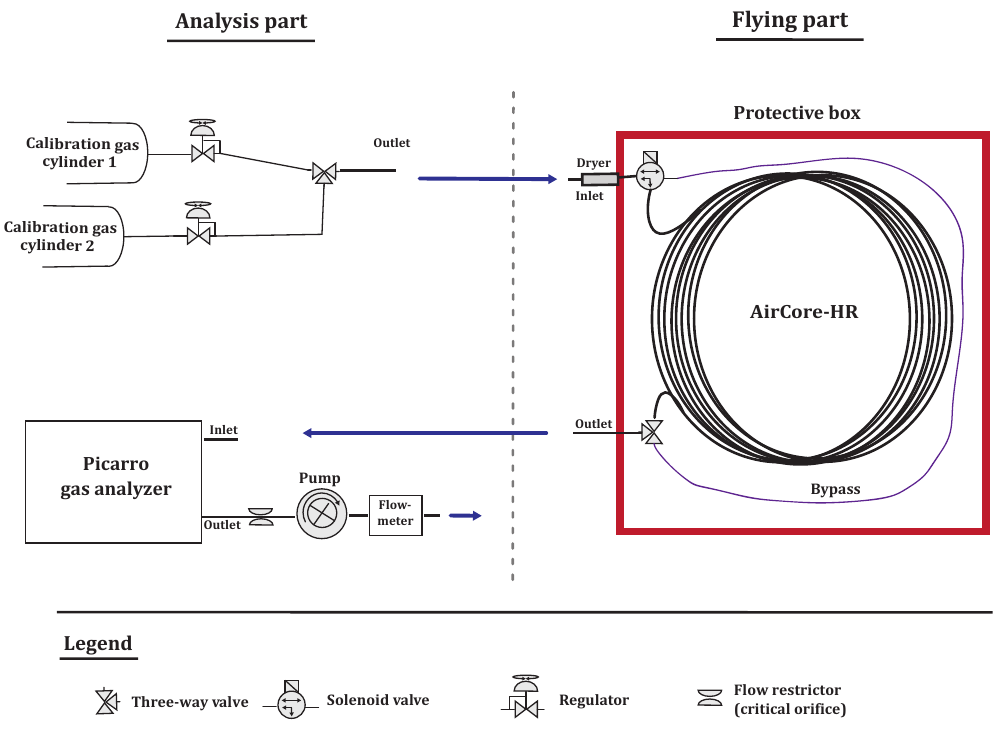
Figure 4. Overview of the AirCore-HR and analysis